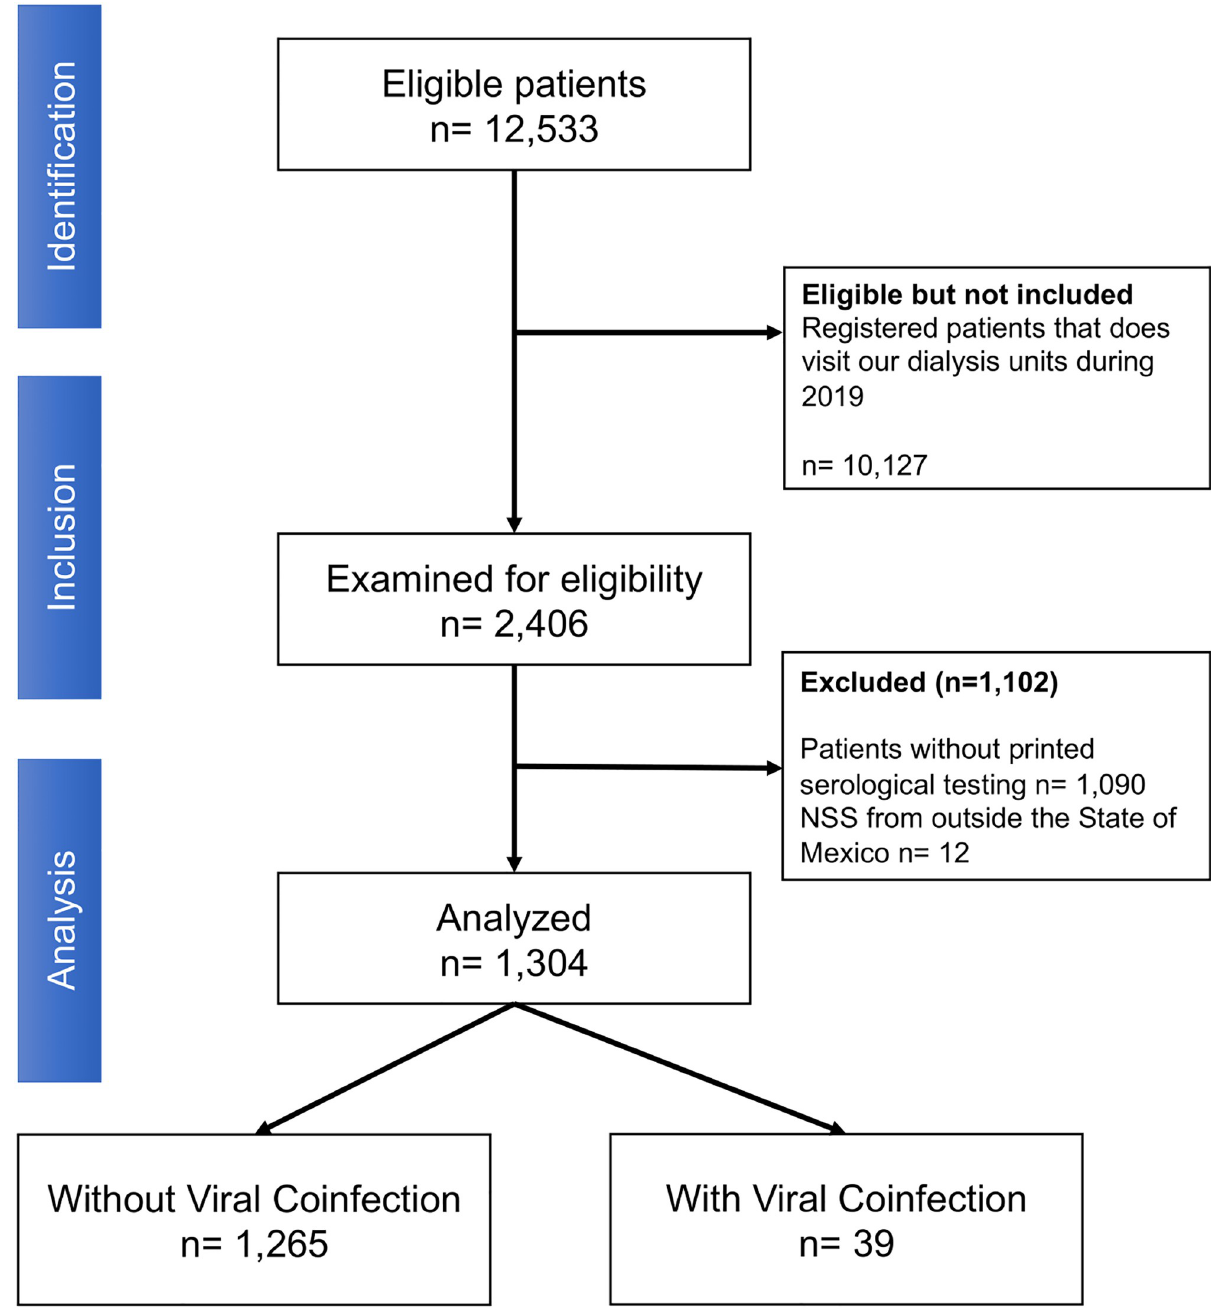
Fig 1. STROBE flow-chart of our studied population submitted to RRT in our 21 dialysis units in the State of Mexico. patients were coinfected with HBV and HCV and one with HCV and HIV, which were excluded from the prevalent coinfection analysis. We observed that patients with any viral coinfection trend to had higher time since RRT (median 4.34; IQR: 1.85–8.17 years), and a more increased residual diuresis (median 200, IQR: 0–700 ml/day) along with a higher propor- tion of anemia (54.8%) compared with patients without any-coinfection (Table 1). Regarding